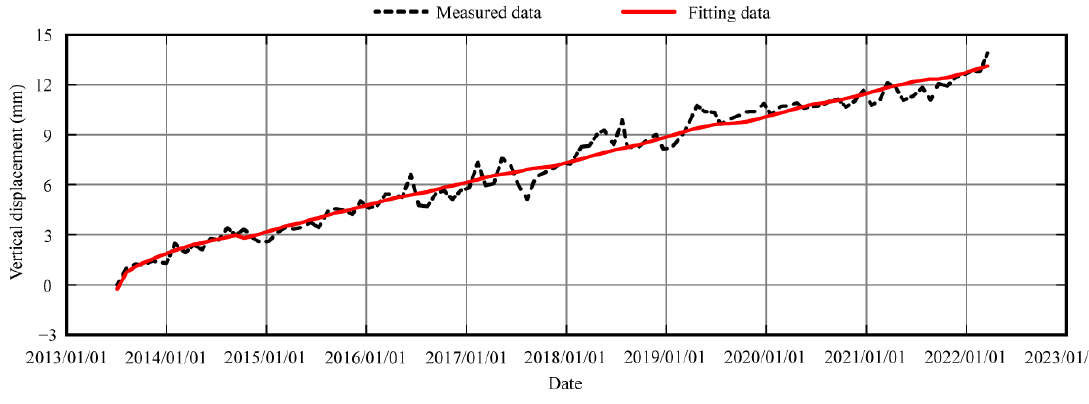
Figure 5. Process lines of settlement for measuring point LD12ZT01 (PLSR model).